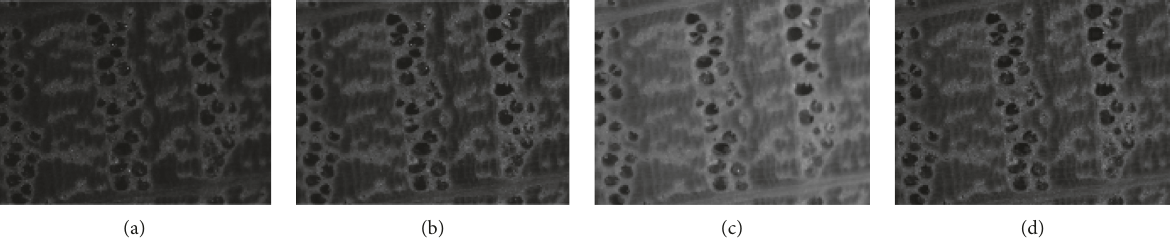
, (b) Band X , (c) Band X , and (d) fused image, taking a three- 1 2 3